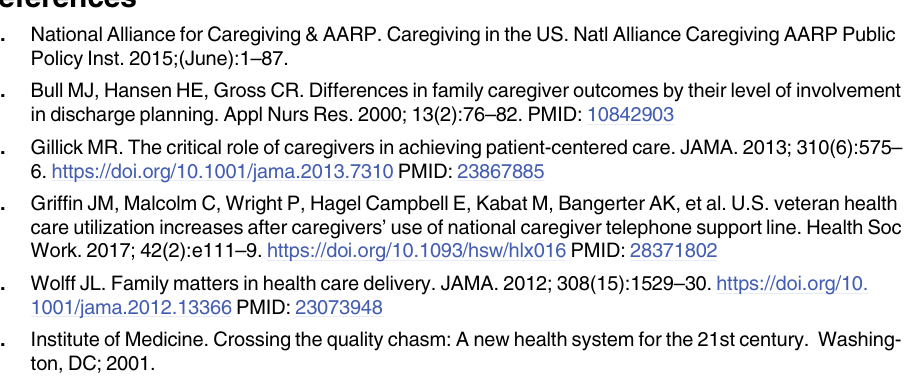
S1 Table. Survey items from the family and caregiver experience survey (FACES) included in this analysis. Excerpt of items in the full FACES survey. S2 Table. Associations between addressable factors and satisfaction with inpatient care in a multivariable logistic regression model, considering each training domain as a separate variable. Model included the addressable factors displayed in the table and adjusted for kin- ship to care recipient and veteran TBI